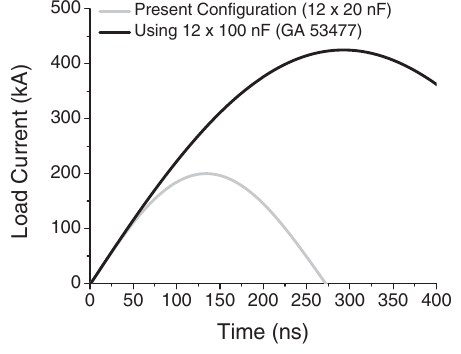
FIG. 8. SCREAMER outputs comparing the present configura- tion of GenASIS with a larger capacitance